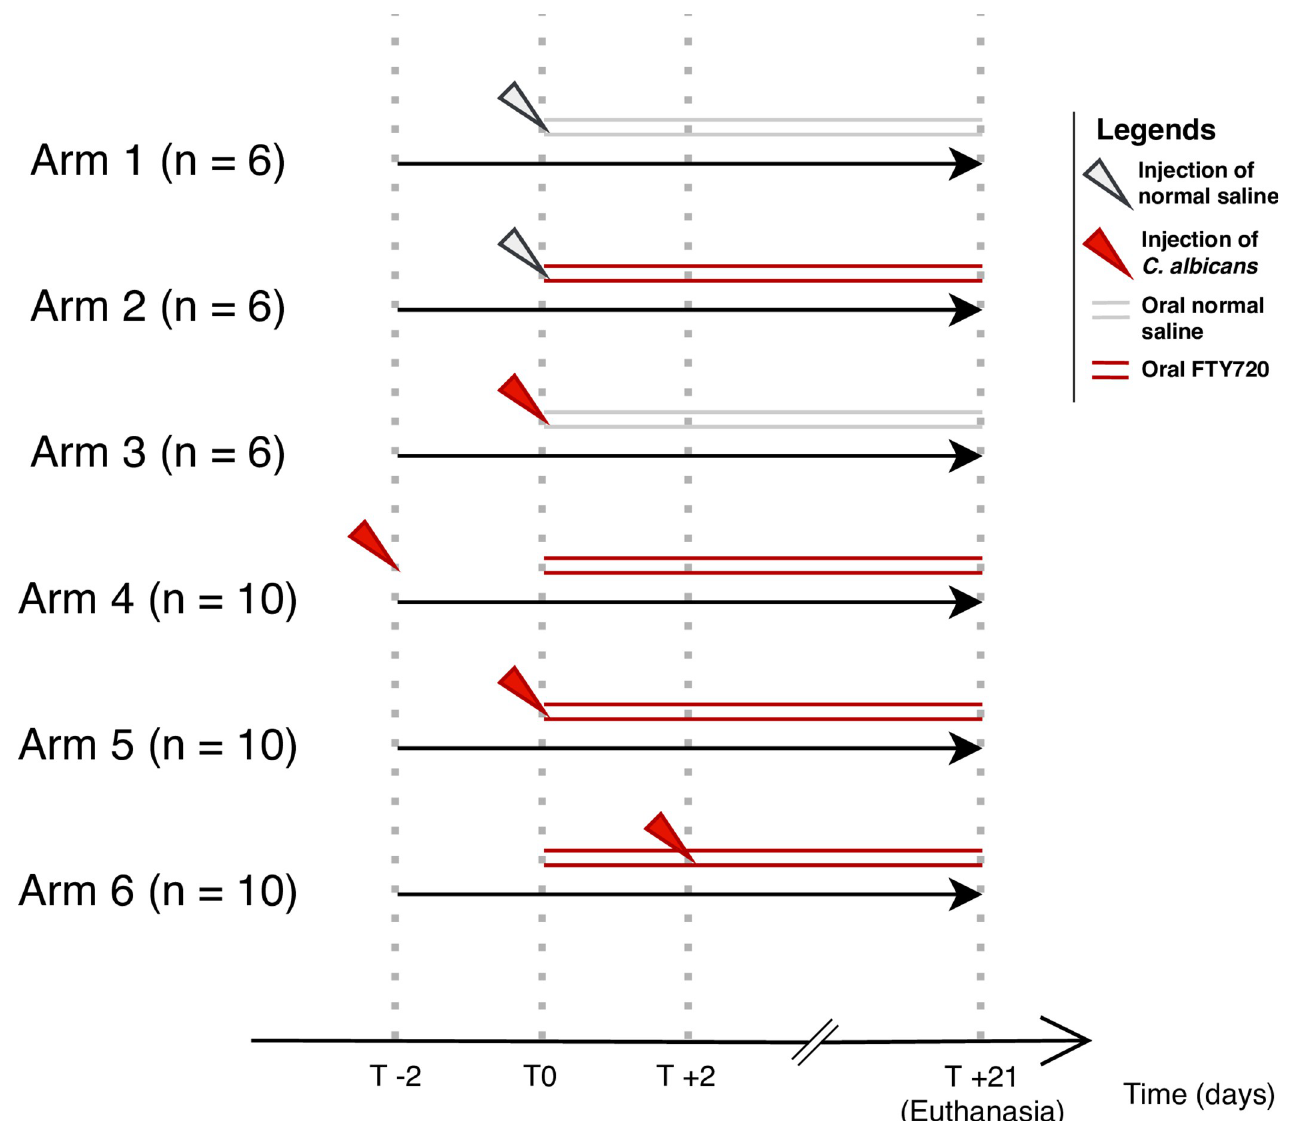
Fig 1. Schematic overview of the parallel intervention arms of the in vivo study. https://doi.org/10.1371/journal.pone.0278488.g001 were created in the plates using a sterile short (2 mL) Pasteur pipette. Then, using a standard sampler, one well was filled with normal saline as control and the others were filled with 200 μ L suspensions of FTY720 with serial concentrations from 0.005 to 1.5 mg/mL. The pres- ence or absence of a zone of inhibition around each well was determined without visual aid, after a 30-hour incubation of the plates at 37˚C. The lowest concentration for which a zone of inhibition surrounded the corresponding well was considered as the probable MIC. 2.2.2 Broth microdilution assay. After obtaining the probable MIC using the well diffu- sion assay, a broth microdilution assay was performed following the methods described by the European Committee on Antimicrobial Susceptibility Testing (EUCAST) [22]. Briefly, micro- tubes in a sterile microtube plate were filled with 10 μ L inocula of C . albicans (0.5 McFarland standard; 1–5 x 10 6 CFU/mL), 90 μ L of Sabouraud dextrose broth (SDB) (Scharlau, Turkey),